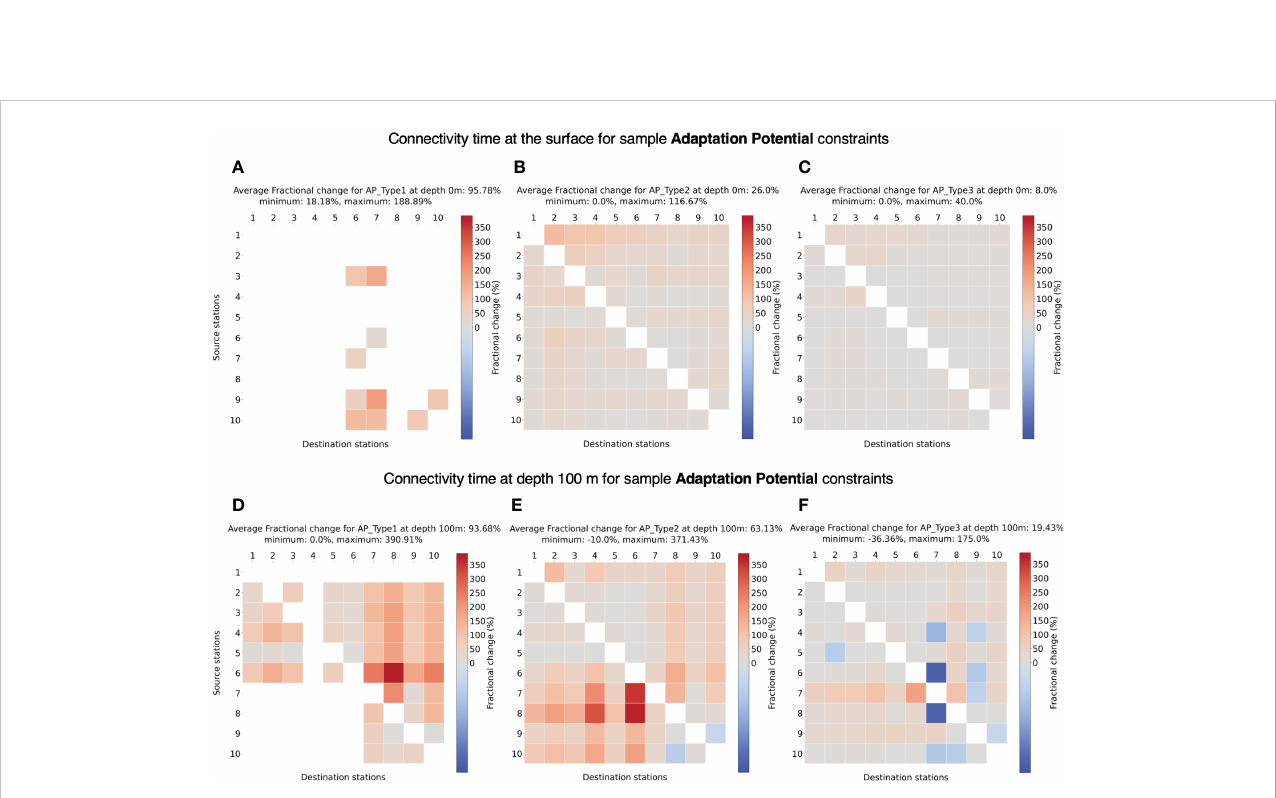
FIGURE 9 (A-C) Fractional change in minimum connectivity time at the surface compared to the non-constrained surface connectivity case in Figure 4A for sample adaptation potentials AP Type 1-3 . (D-F) Fractional change in connectivity time at depth 100 m compared to the non-constrained surface connectivity case in Figure 4A for sample adaptation potentials AP Type 1-3 . The details of these niches are listed in Table 2. The stations are in the ascending order of their